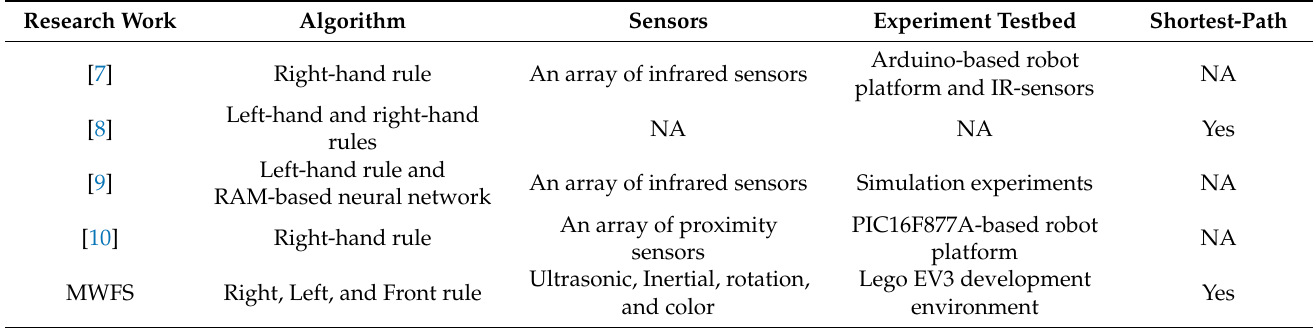
Table 9. A comparison between the recently developed wall-follower